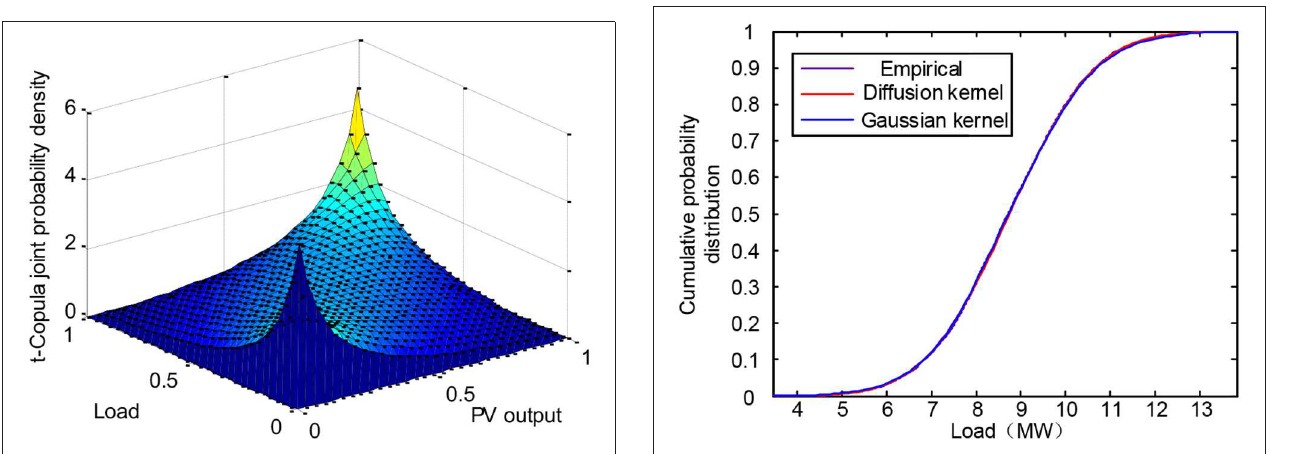
FIGURE 5 | Probability distribution of